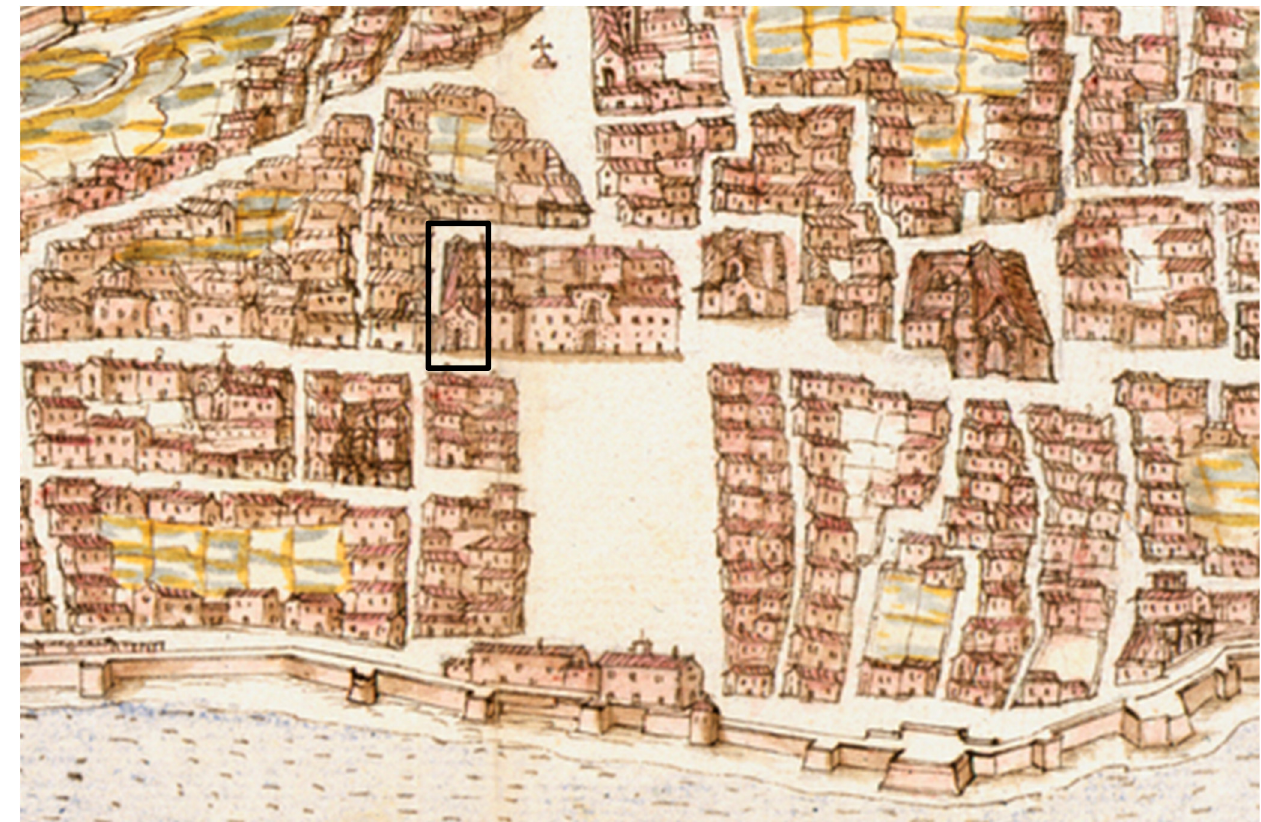
Figure 2. The Church of la Vera Cruz (highlighted) in a detail of Luis Bravo de Acuña’s 1627 plan of Gibraltar. British Library, London, Cartographic Items Additional MS 15152, f. 23r [© British Library, London].